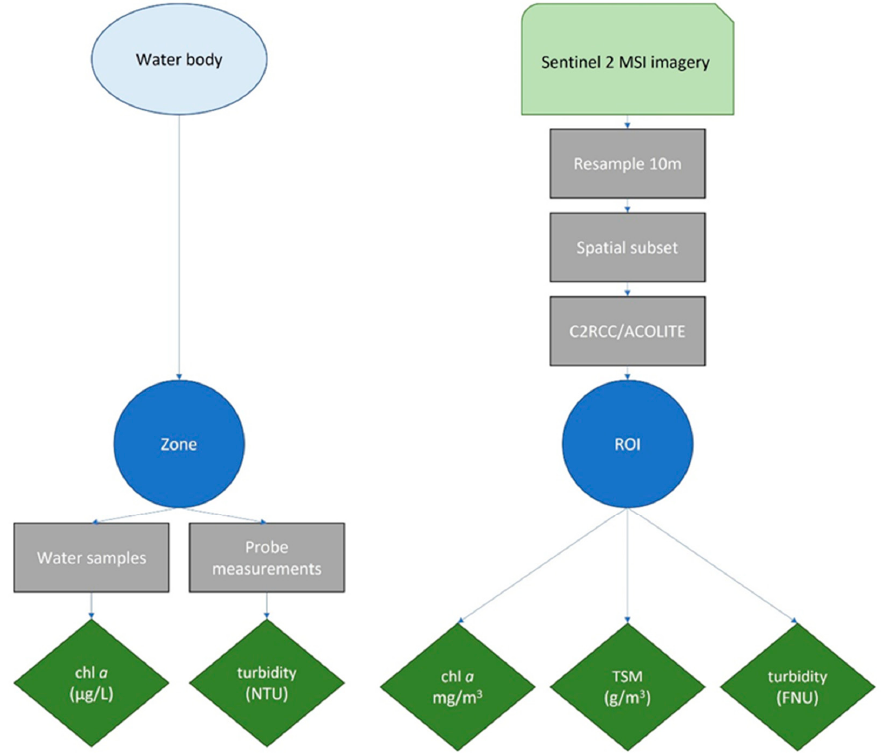
Figure 2. Workflow of in situ data collection and analysis and satellite imagery processing. In situ measurements, chlorophyll a concentration is measured in µ g/L and turbidity in NTU. Image processing estimated chlorophyll a concentration is measured (mg/m 3 ), total suspended matter in (g/m 3 ), and turbidity in FNU (ROI means ‘region of interest,’ the drawn polygons).